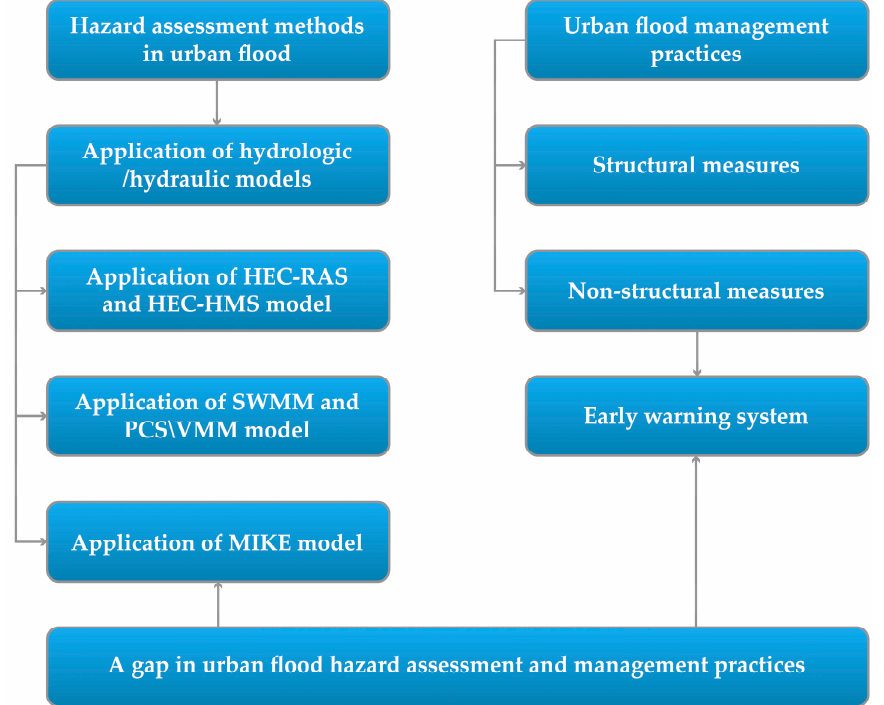
Figure 3. A research framework for assessing and analyzing urban flood hazard assessment and management practices in South Asian cities.